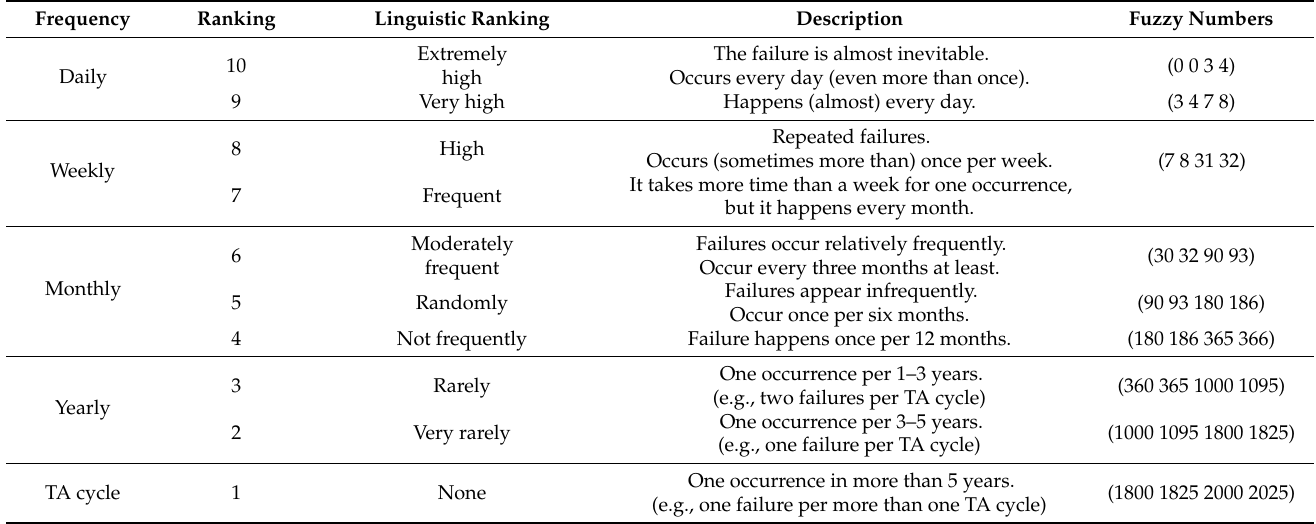
Table 4. Selection criteria for failure modes occurrence evaluation.